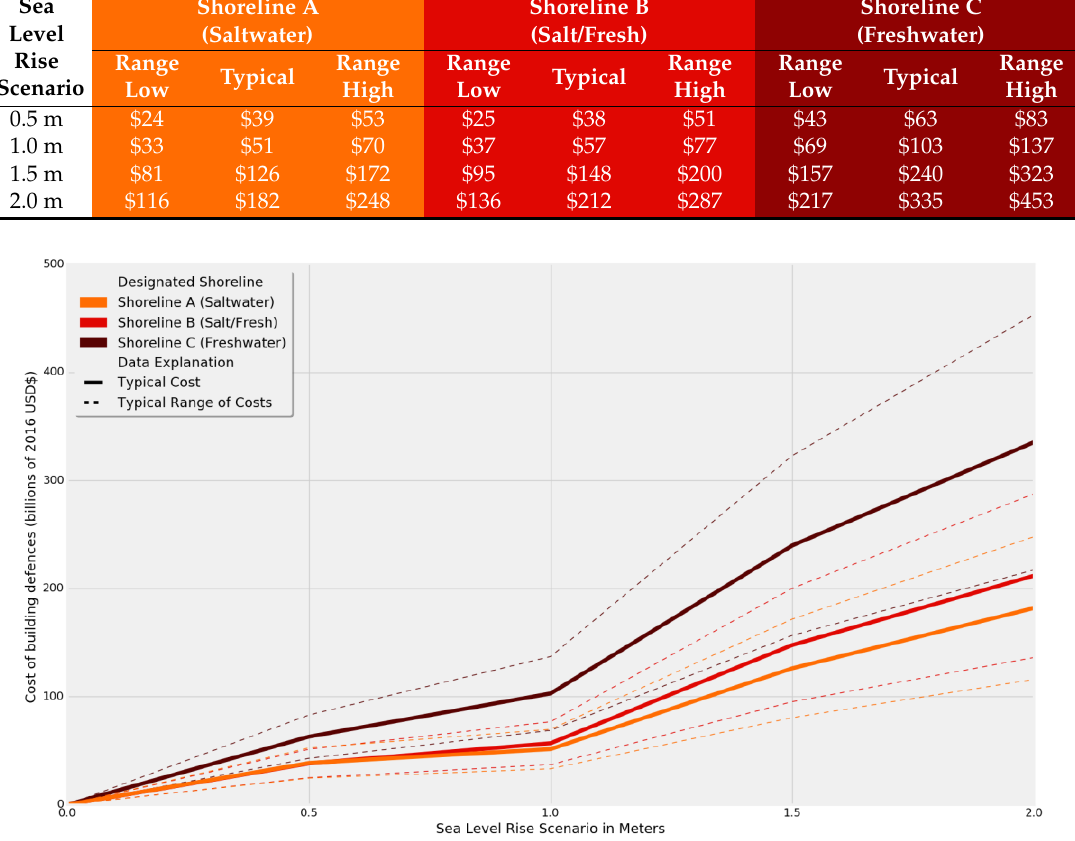
Figure 10. Figure comparing the average and the range of potential costs to raise the protective infrastructure along each of the three different shorelines. Costs are based on current infrastructure type—landform or wall—being raised to meet future water levels in a no-storm-surge condition and sea level rise scenarios. The cost estimates are done using Approach #4 and are shown as billions of 2016 USD$.